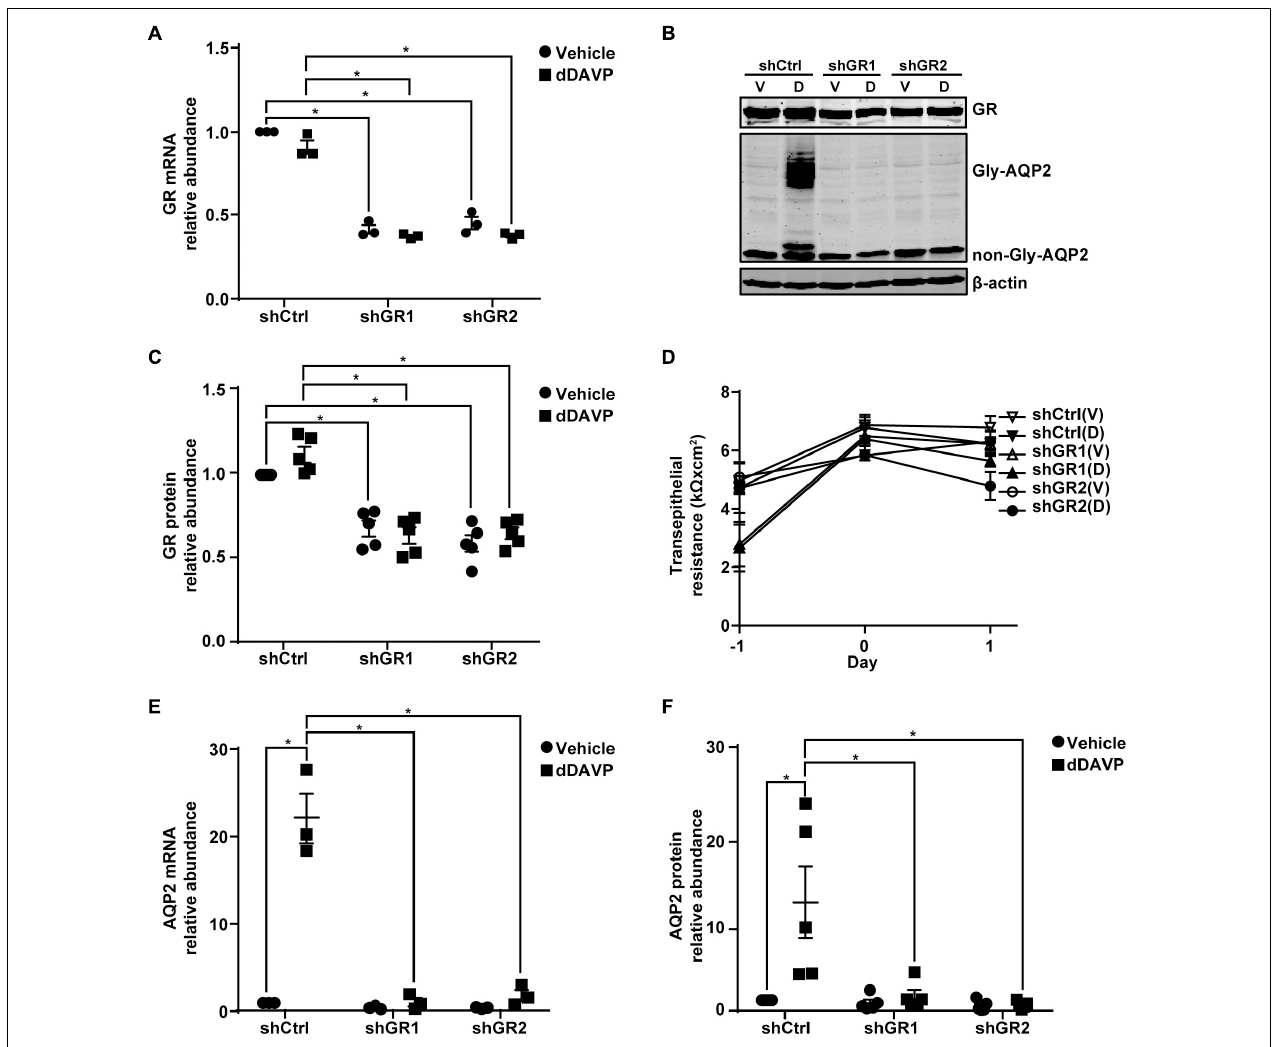
FIGURE 6 | Glucocorticoid receptor knockdown reduced vasopressin-induced AQP2 gene expression in the mpkCCD cells. (A,E) Quantitative RT-PCR measurements of glucocorticoid receptor (GR) and AQP2 mRNA in control (shCtrl) and GR knockdown (shGR) cells in response to vehicle vs. 1 nM dDAVP. Two shGR sequences were used (shGR1 and shGR2). Numbers are means ± SEM, summarized from three independent experiments. Two-way ANOVA was used for statistical test. Asterisks indicate statistical significance between samples ( p < 0.05, t -test). (B,C,F) Representative immunoblots and summaries of GR and AQP2 in shCtrl and shGR cells in response to vehicle (V) vs. dDAVP (D). Gly-AQP2 and non-Gly-AQP2 are glycosylated and non-glycosylated AQP2, respectively. Numbers are means ± SEM, summarized from five independent experiments. (D) Transepithelial electrical resistance of the cells grown on Transwell R (cid:13) prior to vehicle